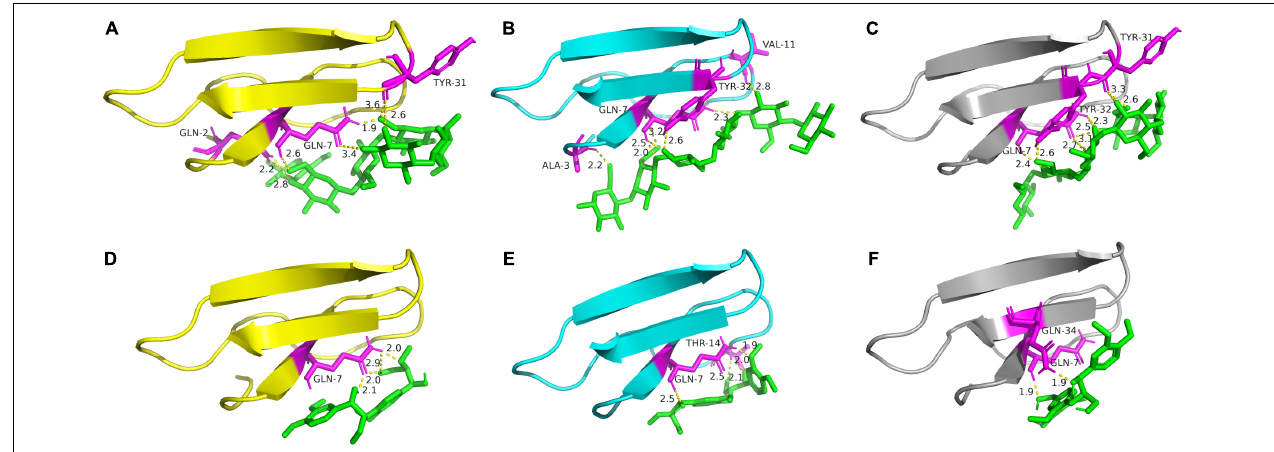
FIGURE 7 | Binding conformations of cellohexaose to TrCBM (A) , PoCBM (B) , and PfCBM (C) , and the conformations of LGG to TrCBM (D) , PoCBM (E) , and PfCBM (F) . The interacted amino acids are shown in